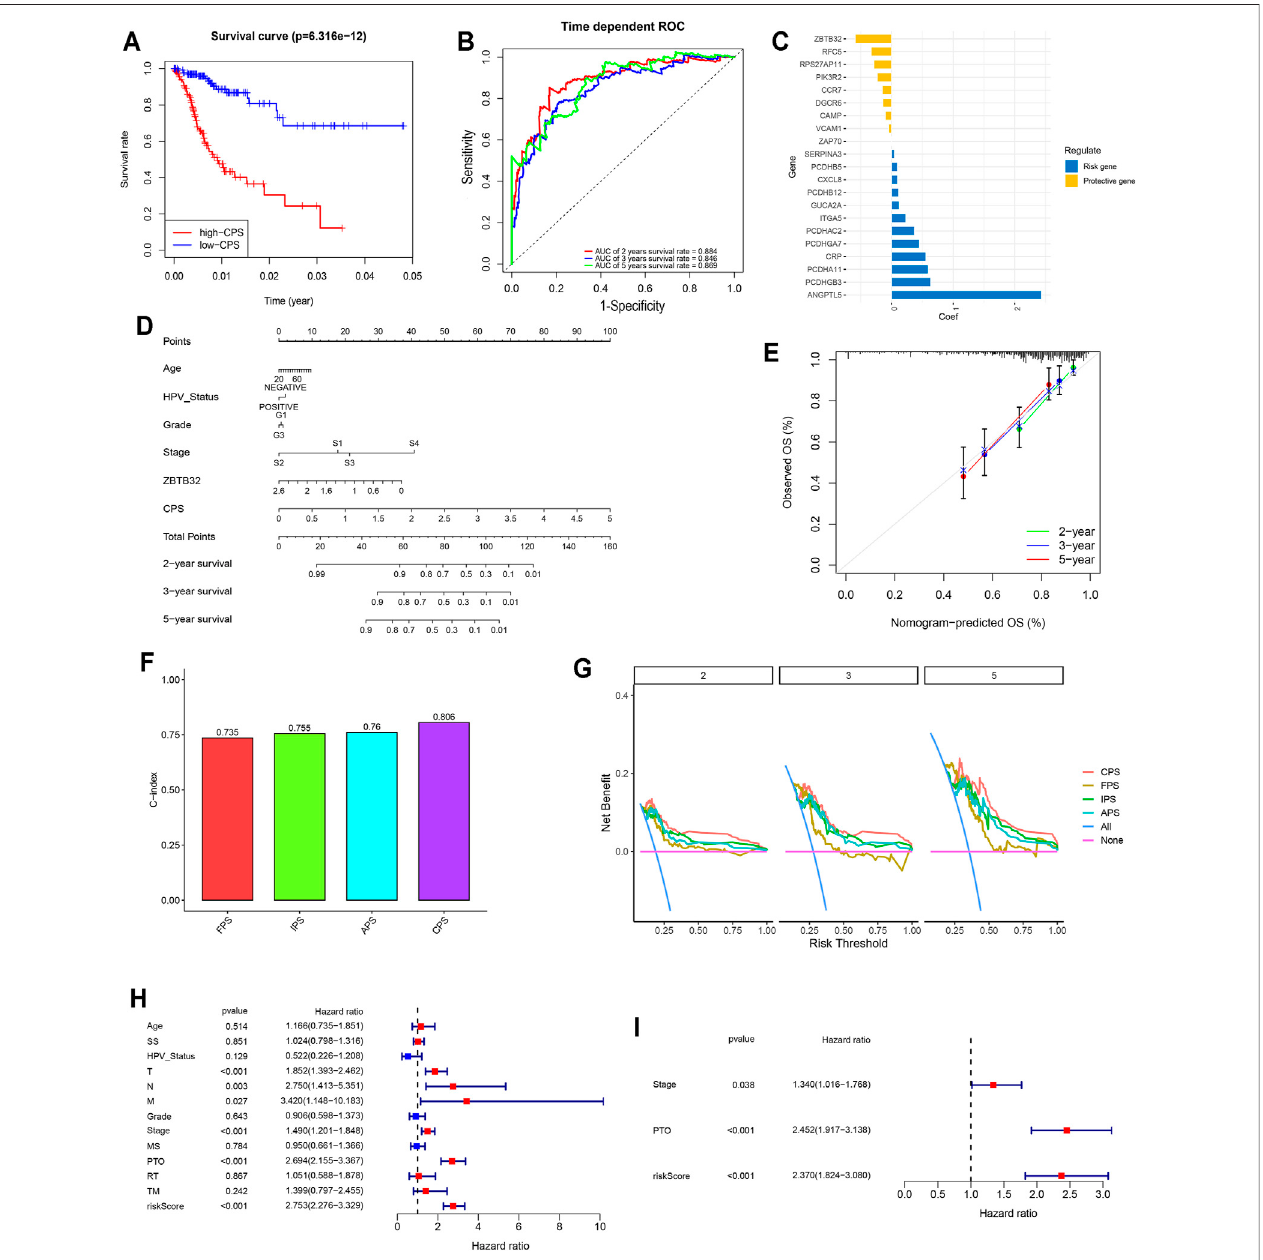
FIGURE 5 | Comprehensive signature was identi fi ed based on FARGs and played vital roles in the prognosis of CC. (A) Kaplan-Meier survival curves for patients with high and low CPS based on gene signature. (B) ROC curves based on CPS for 2-, 3-, and 5-years survival probabilities. (C) The detailed coef fi cient calculated by multivariate Cox regression using LASSO. (D) The nomogram prognosis prediction model. (E) The calibration plots suggested the comparison between prediction and actualoutcomefor2-,3-,and5-yearssurvivalprobabilitiesinthenomogrammodel. (F) C-indexcomparisonofFPS, IPS,APS,andCPS. (G) DCAcurvesindicated the comparison between four prediction risk scores. (H,I) The univariate (H) and multivariate (I) Cox regression analysis between clinical features and OS. SS, smoking status; MS, menopause status; PTO, primary therapy outcome; RT, radiation therapy; TM, target or molecular therapy.